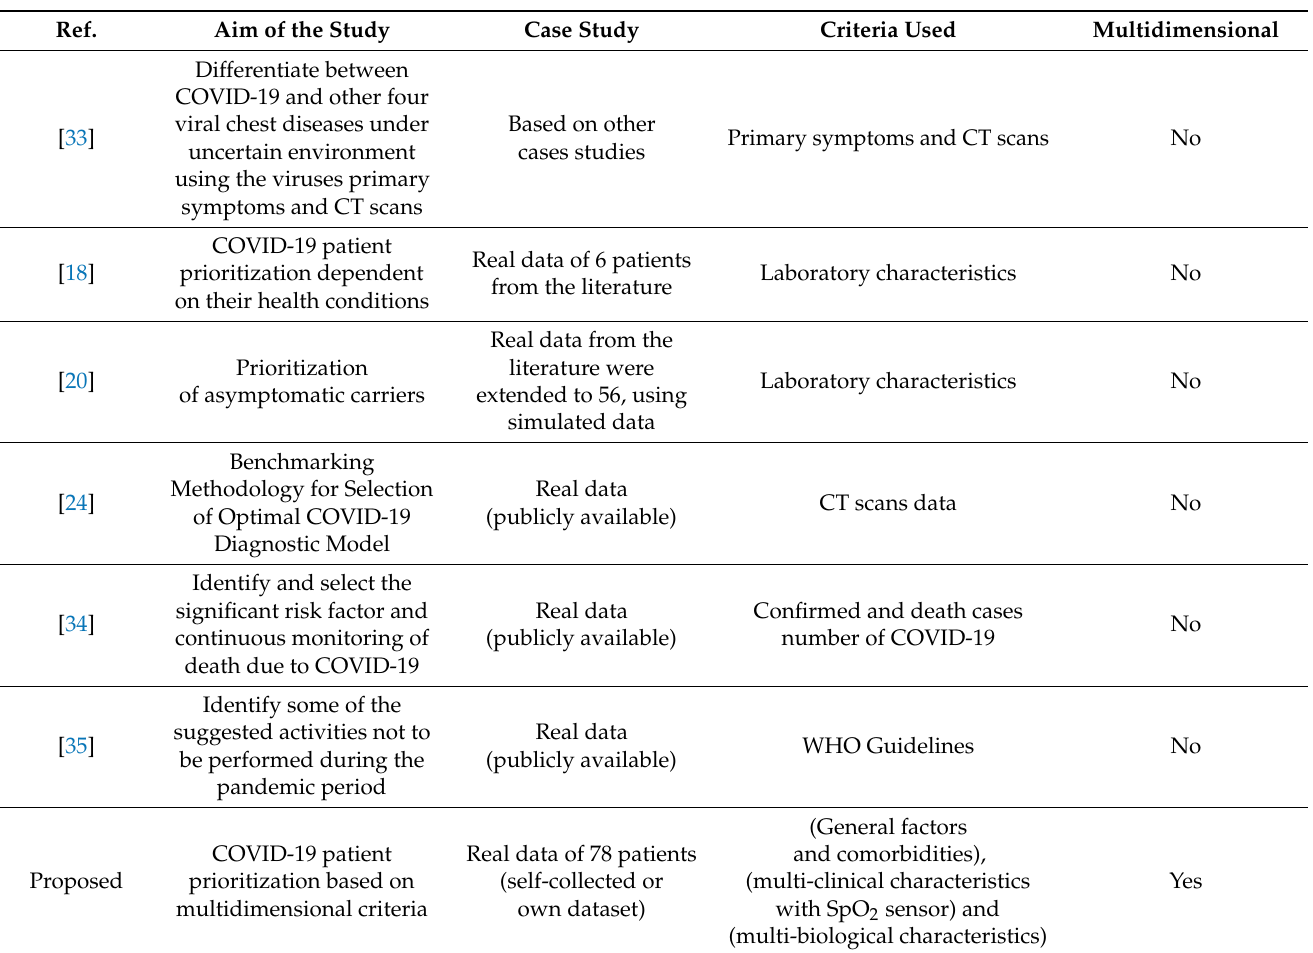
Table 1. Related works on COVID-19 identification and